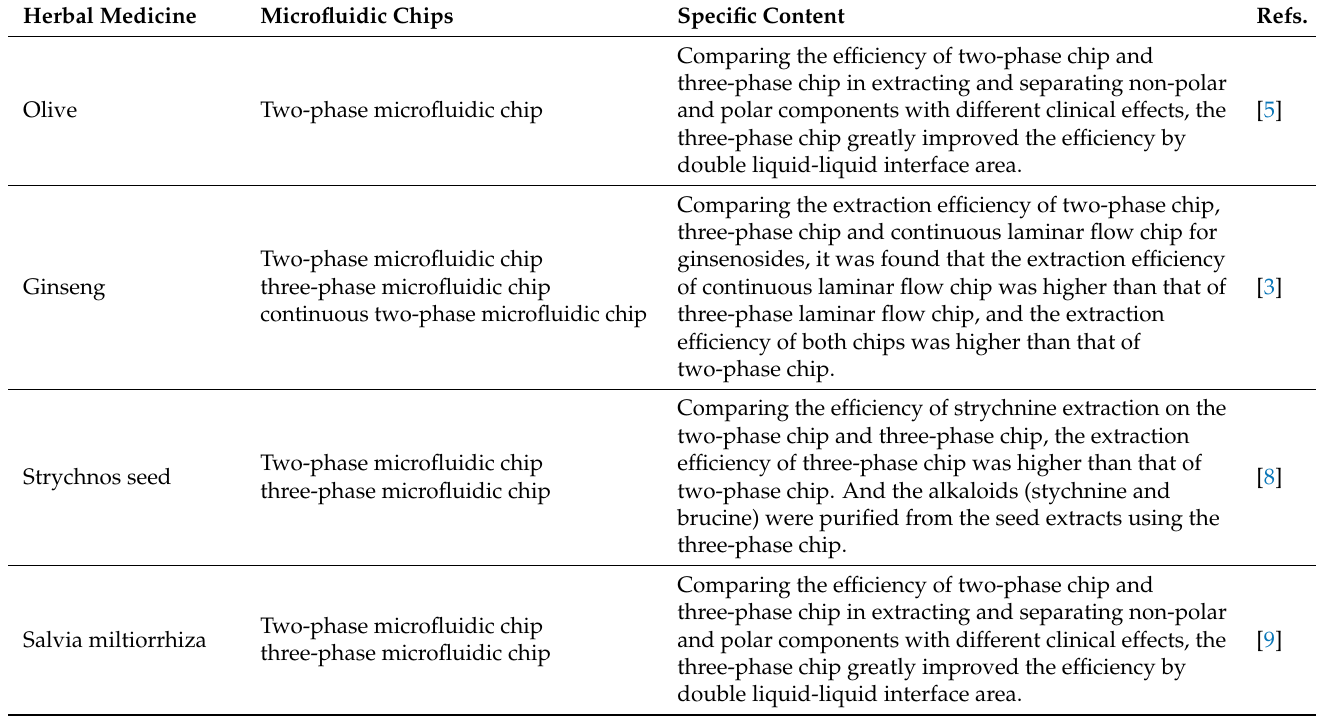
Table 2. Microfluidic chips for the separation and purification of active ingredients.